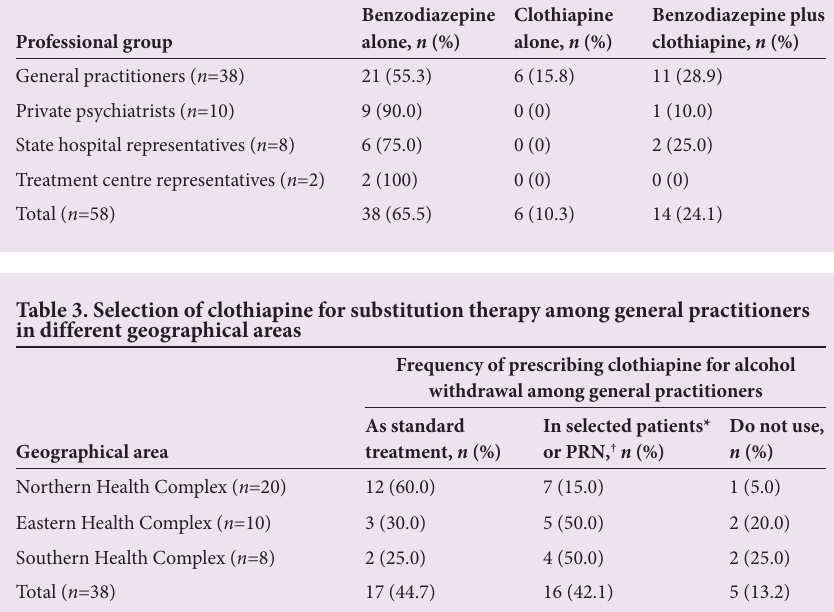
Professional group